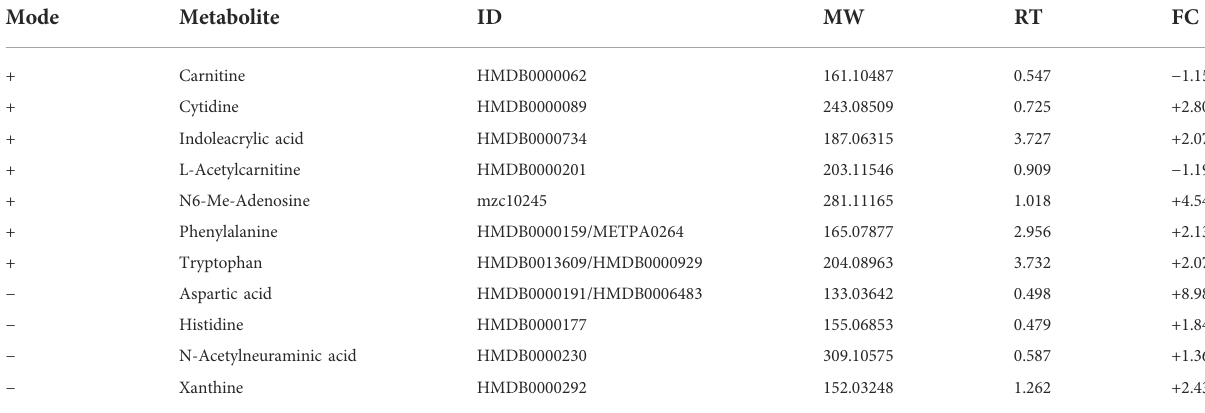
TABLE 6 List of metabolites in OT against